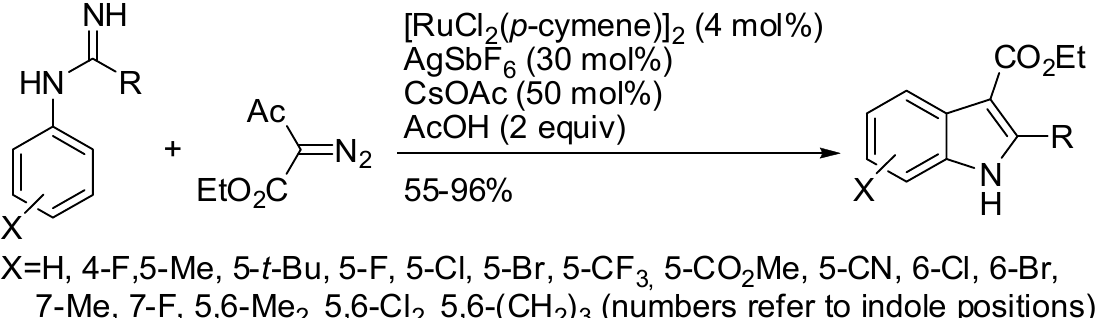
Scheme 66. Ruthenium-catalyzed synthesis of indoles from imidamides and diazo ketoesters. Ru catalytic systems are known to promote the intermolecular coupling of anilines with diols to synthesize indole and quinoline derivatives [127–132]. In particular in 2016, Lee and Yi found that also the tetra-nuclear Ru complex [(PCy 3 )(CO)RuH] 4 ( μ -O)( μ -OH) 2 catalyzed this synthesis in the presence of cyclopentane as an oxidant (Scheme 67) [133]. The indole products were regioselectively formed with the carbon carrying the secondary alcohol moiety in the 2-position. Some experiments were carried out by the authors to describe a plausible mechanistic hypothesis as depicted in Scheme 67.